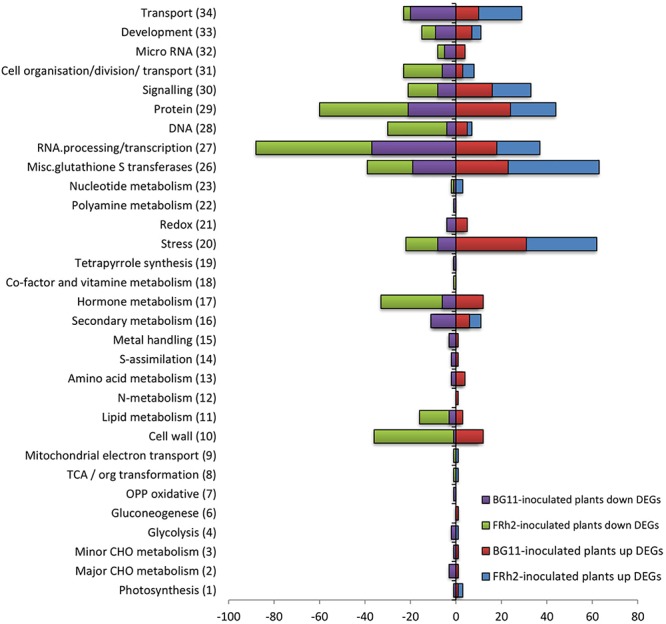
Numbers of differentially expressed genes (DEGs) assigned into MapMan bins (bin number in brackets) from FRh2- and BG11-inoculated plants. Downregulated DEGs are negative. Unassigned DEGs were 142, –225, and 61, –98 for FRh2- and BG11-inoculated plants, respectively. OPP, oxidative pentose phosphate; TCA/org transformation, tricarboxylic acid cycle/organic acid transformation.